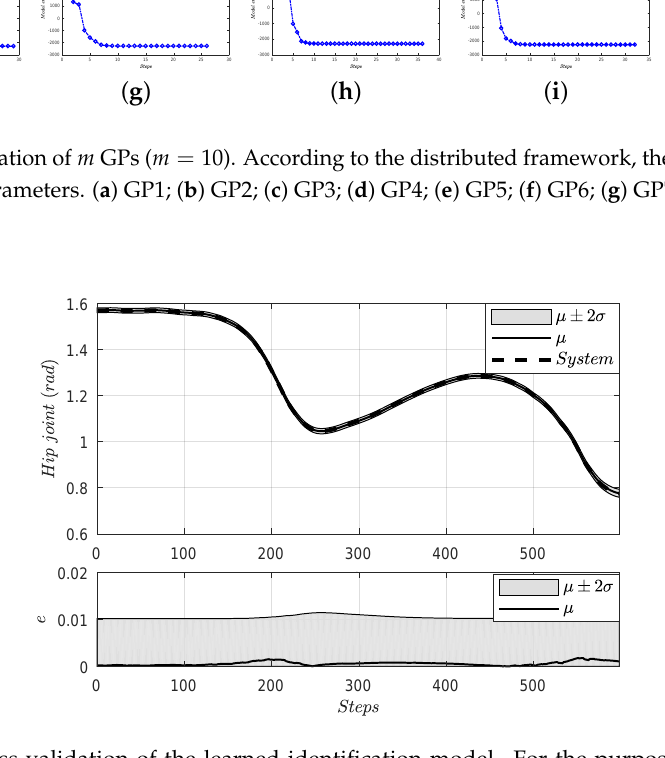
Figure 10. Cross-validation of the learned identification model. For the purpose of verifying the learning result of the identification model, we conduct a cross-validation with 600 successive data pairs. The state-space inferences of the hip joint, ground truth and the prediction error are presented in the above